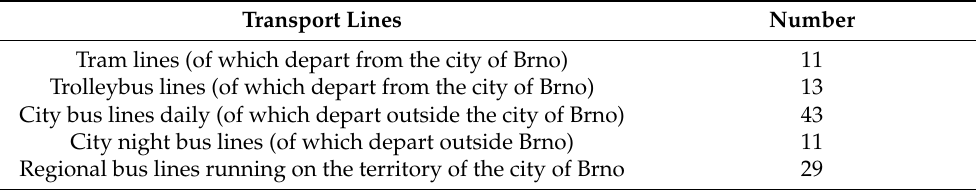
Table 1. Number of transport lines in Brno city based on DPMB data – prepared by authors [53,55,56]. Transport Lines Number Tram lines (of which depart from the city of Brno) 11 Trolleybus lines (of which depart from the city of Brno) 13 City bus lines daily (of which depart outside the city of Brno) 43 City night bus lines (of which depart outside Brno) 11 Regional bus lines running on the territory of the city of Brno